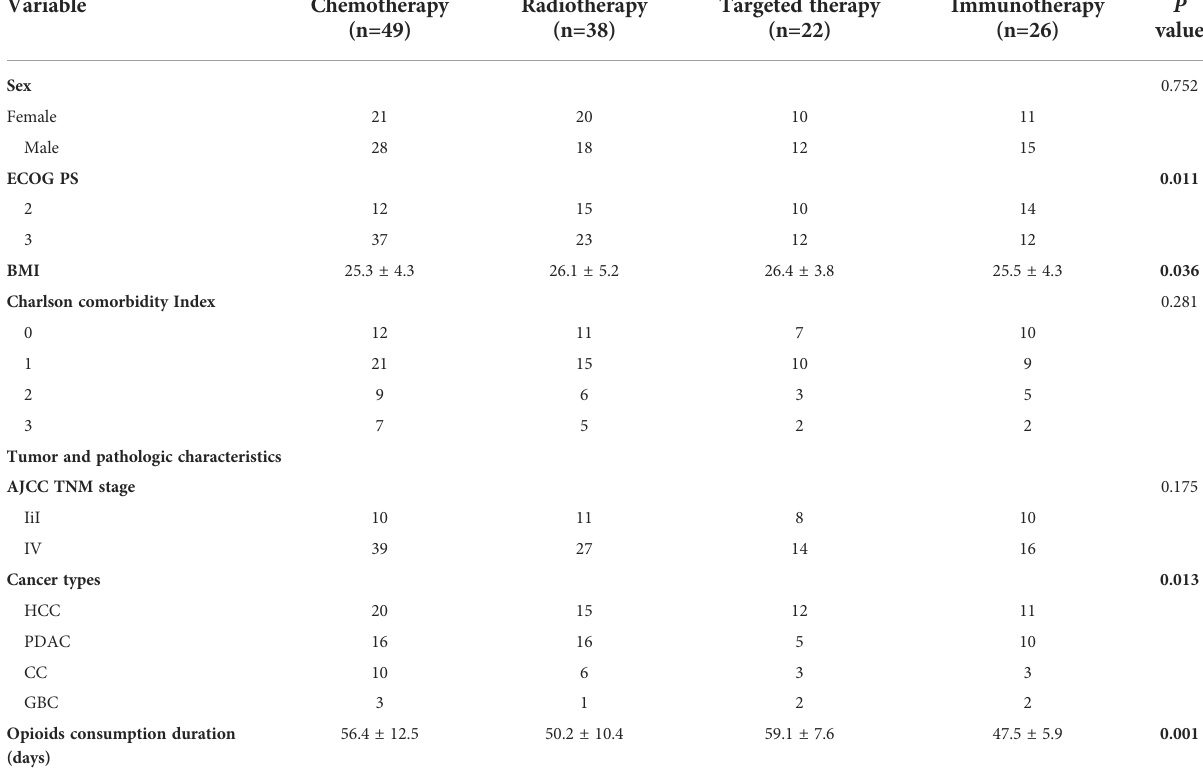
TABLE 1 Demographics and clinical characteristics of enrolled patients who received opioid treatment before PSM.